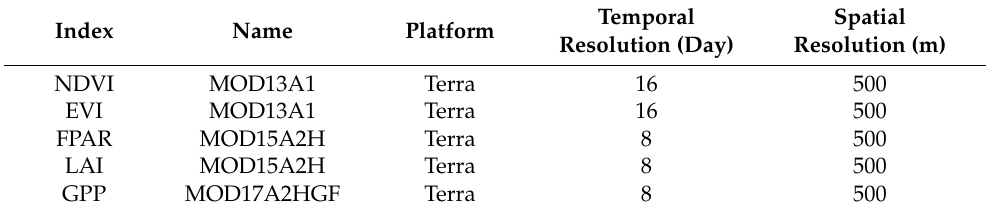
Table 1. MODIS products used to calculate the DHIs.